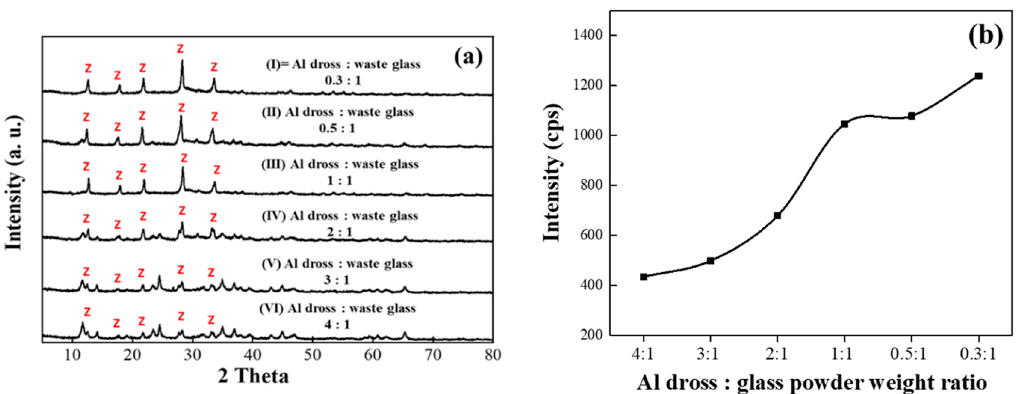
Figure 3. ( a ) X-ray diffraction spectroscopy (XRD) pattern of the synthesized zeolite from the waste to waste stream combination. ( b ) XRD intensity of the primary peak of the XRD.